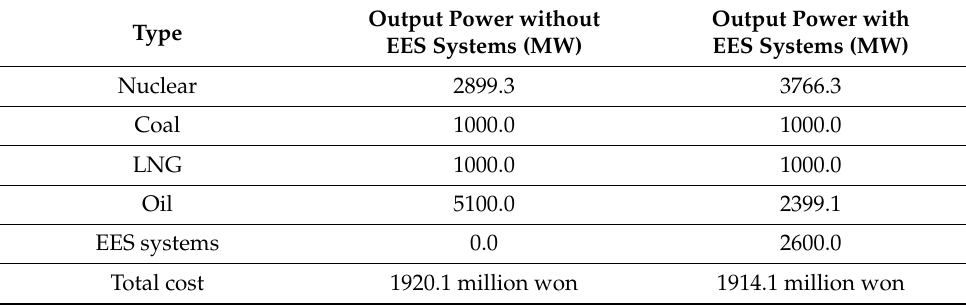
Table 3. Composition ratio of generation units (at a fixed cost of 75,000